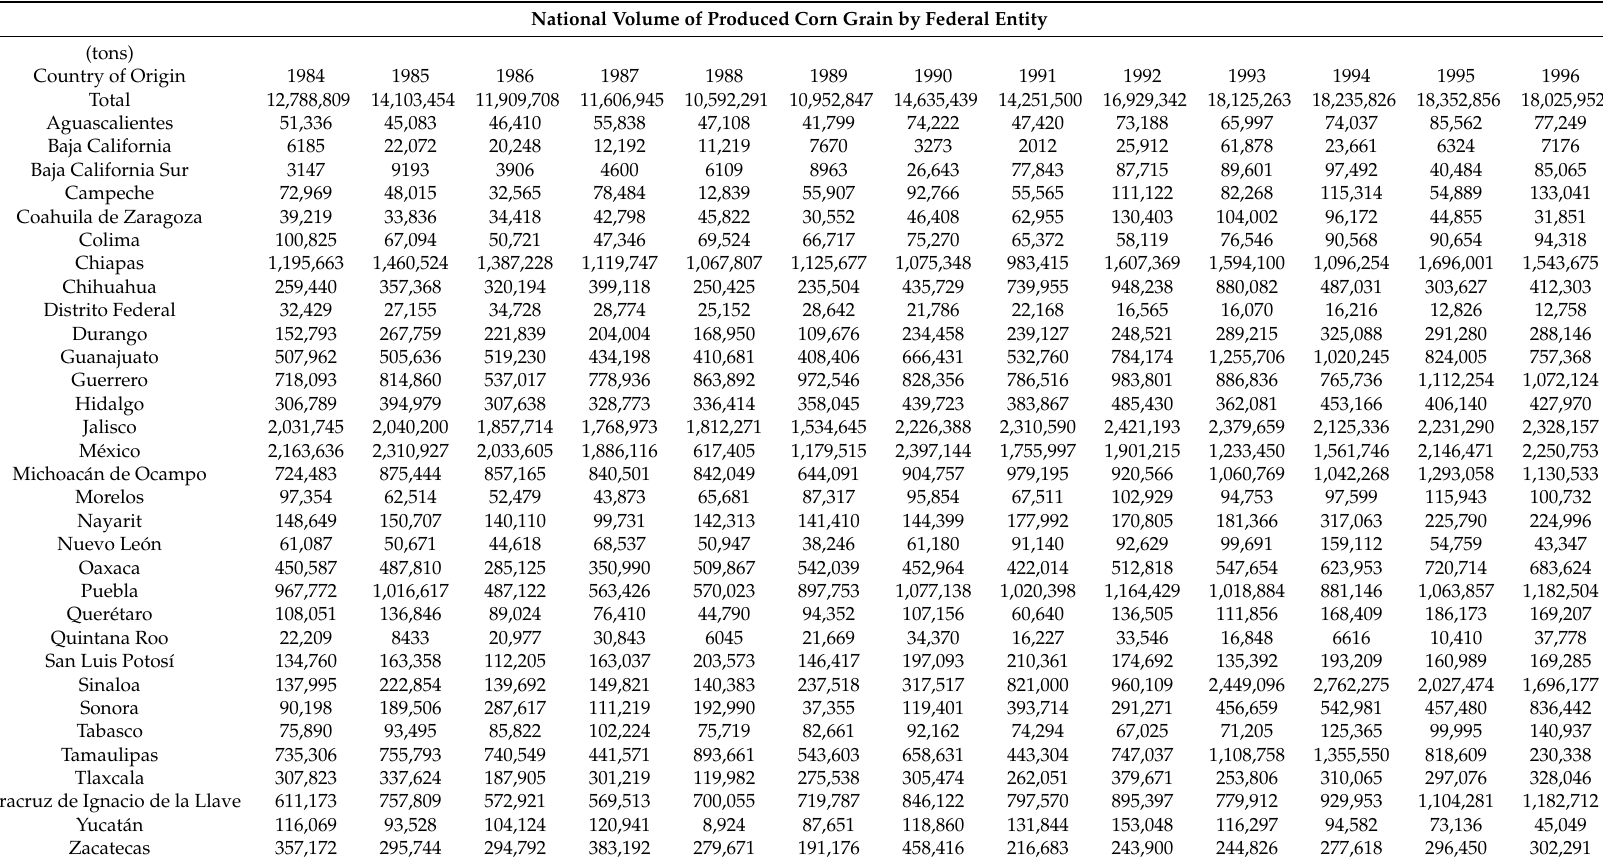
Table A1. Produced Corn Grain by Federal Entity in Mexico